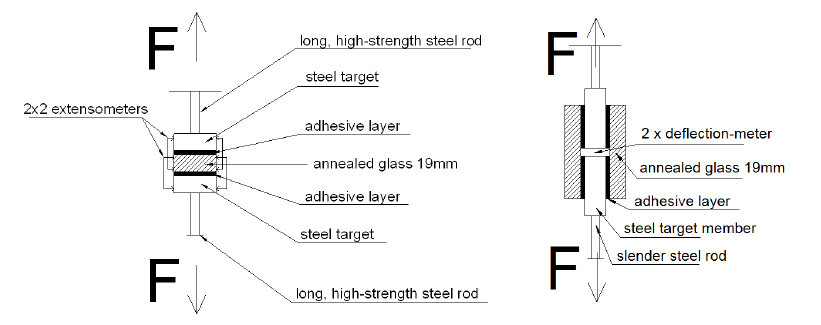
Figure 3: Set-up of the steel-glass connection tests (on the left: tension, on the right: shear). Two different extensometer-systems were used to measure exactly the deformation of the adhesive layer under continuously increasing load. Very sensitive extensometers with small range (usually used for crack opening measurement) were used to measure the rigid connections with epoxy resin or acrylic, see Figure 4a. High-range extensometers was required in case of silicone or polyurethane, where the possible elongation of the connection was much bigger (up to 220%), see Figure 4b and c.